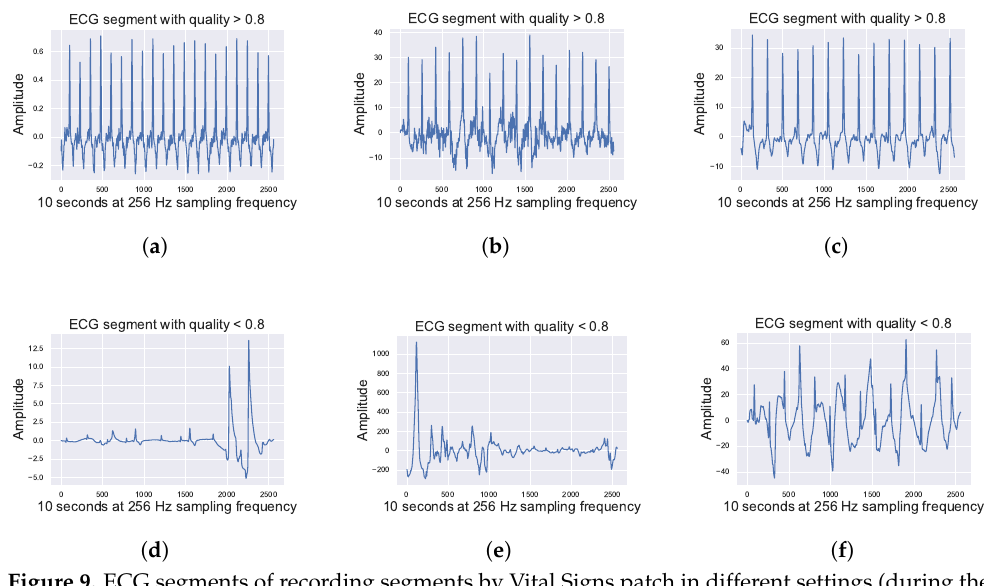
Figure 9. ECG segments of recording segments by Vital Signs patch in different settings (during the day, night, and exercise) with quality higher and lower than 0.8. ( a ) ECG segment during the stress test, quality signal > 0.8. ( b ) ECG segment during the day, quality signal > 0.8. ( c ) ECG segment during the night, quality signal > 0.8. ( d ) ECG segment during the stress test, quality signal < 0.8. ( e ) ECG segment during the day, quality signal < 0.8. ( f ) ECG segment during the night, quality signal < 0.8.